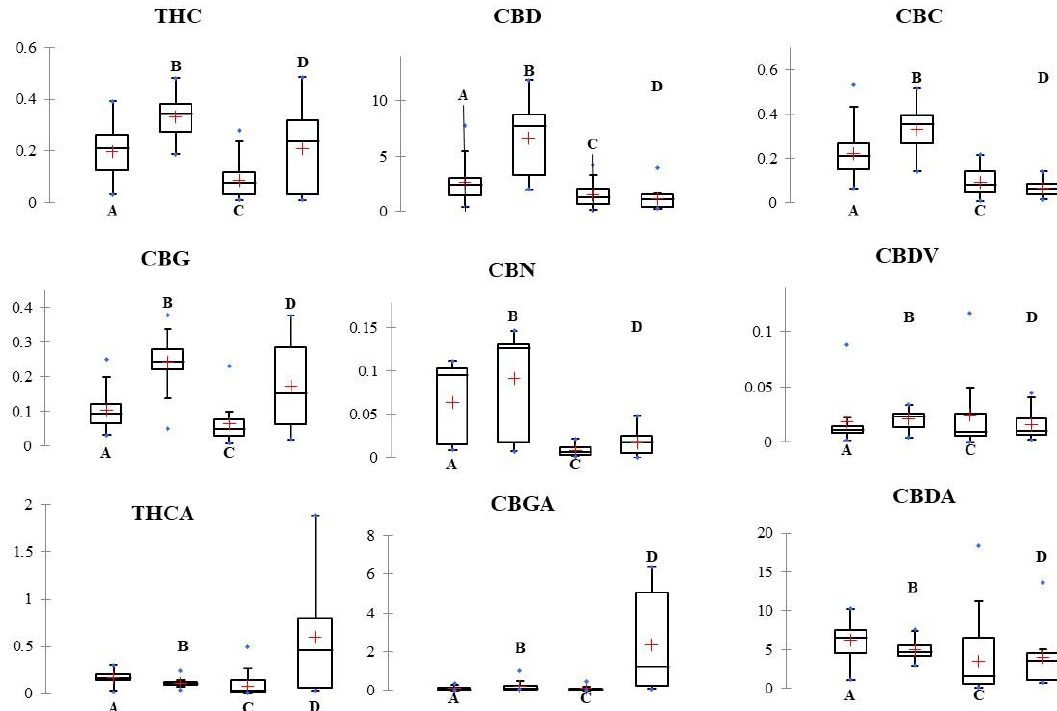
Figure 1. Box and whisker plot of the relative concentrations of the six neutral (THC, CBD, CBC, CBG, CBN and CBDV) and the three acidic cannabinoids (THCA CBGA and CBDA) in the 161 hemp samples. The hemp samples were grouped as sold by the four Italian hemp retailers. Concentration of cannabinoids was reported as % w / w. Y axis title = Concentration (% w / w). X axis Title = Hemp retailers. Median and average were depicted with a flat black line and a red cross, respectively.